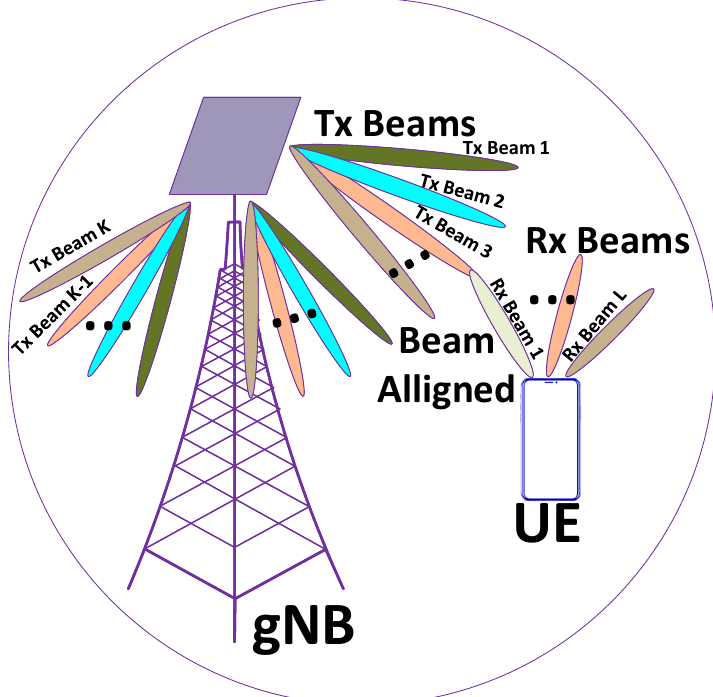
Figure 3. Directional communication with multiple beams in 5G